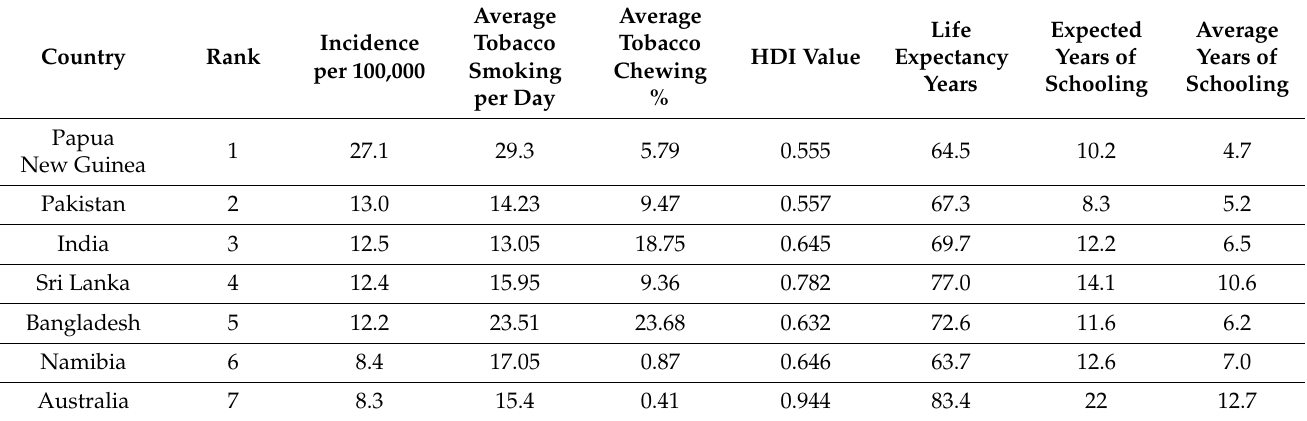
Table 1. Incidence of LOCC, 10 countries with the highest and 10 with the lowest incidence